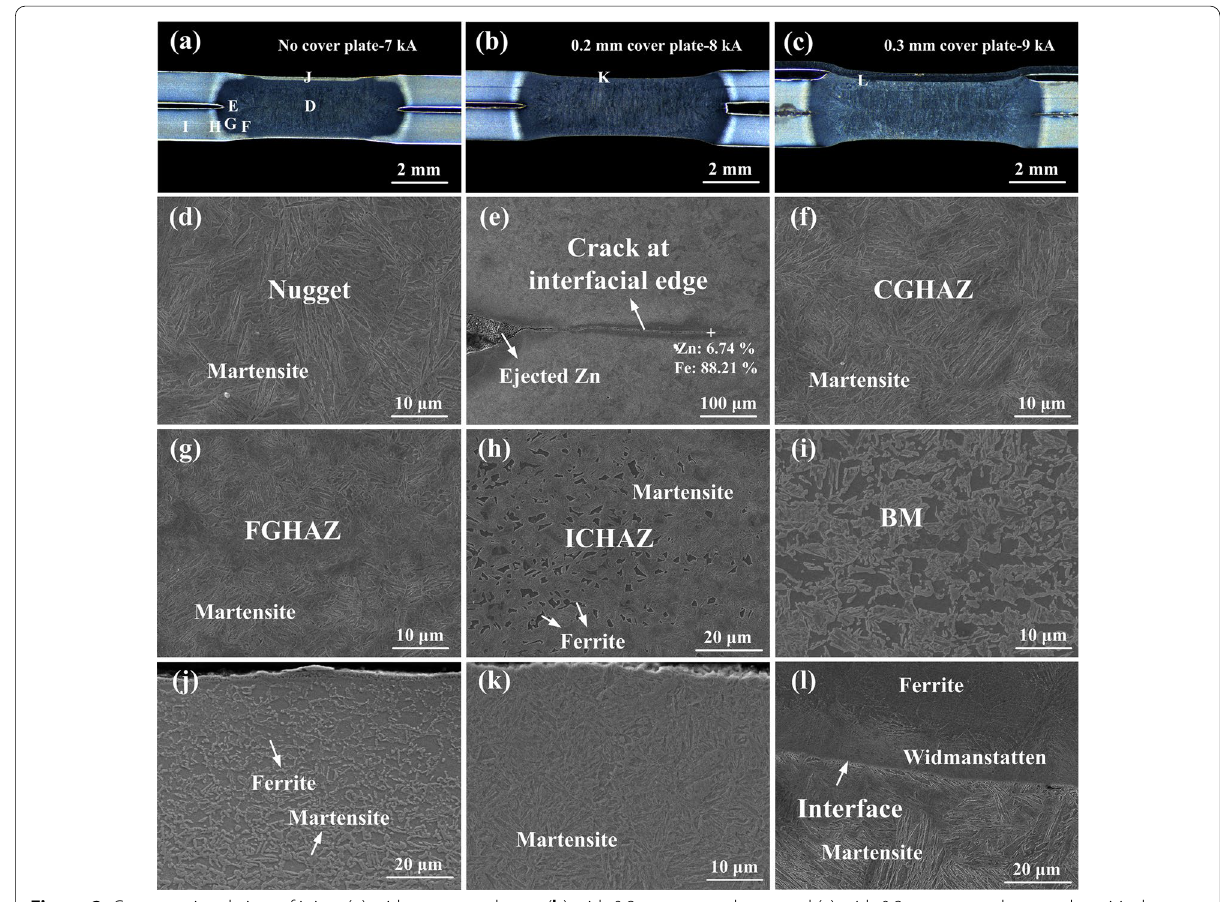
Figure 2 Cross-sectional view of joints ( a ) without cover sheets; ( b ) with 0.2 mm cover sheets and ( c ) with 0.3 mm cover sheet under critical welding current and ( d – j ) microstructure corresponding to the locations D-J in a ; k , l microstructure corresponding to the locations K in b and L in